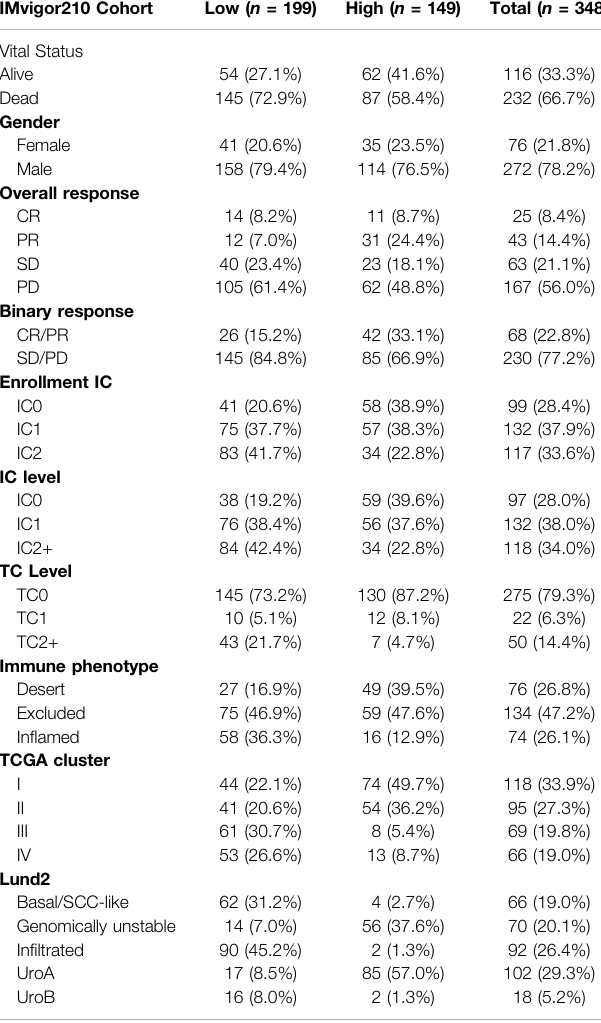
TABLE 2 | Summary of detailed clinical information of IMvigor210 (mUC)